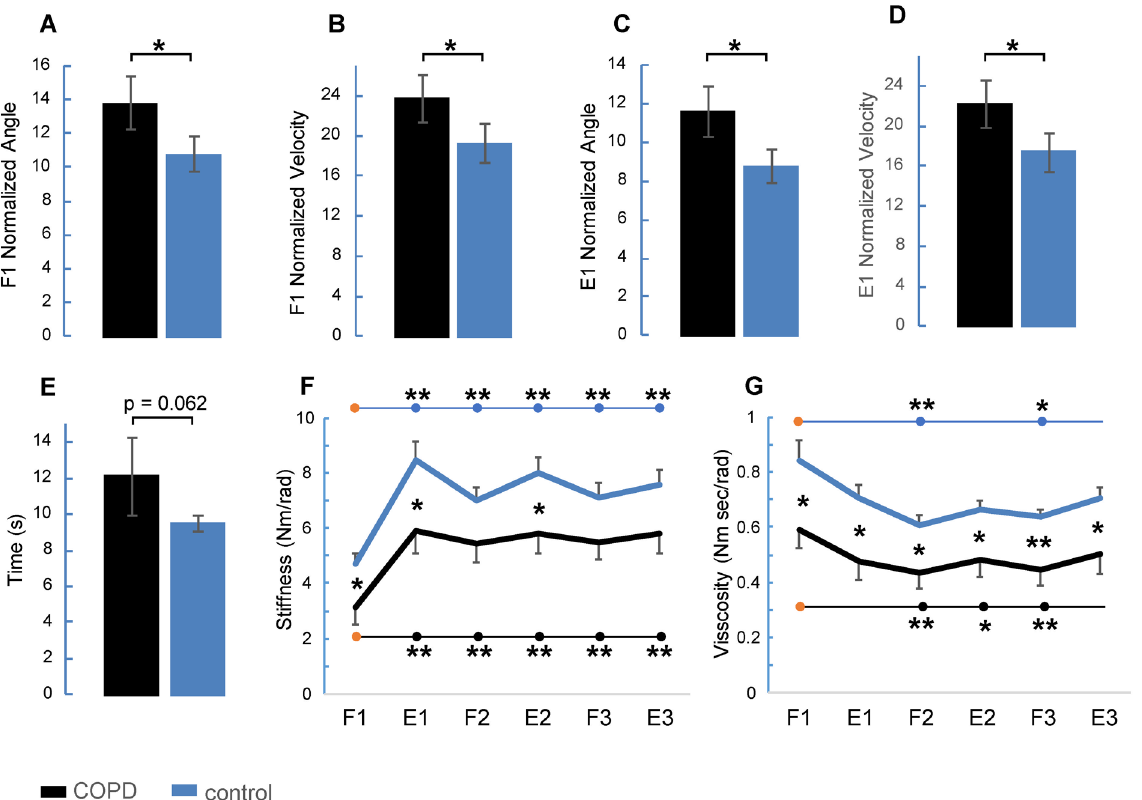
Figure 3. Statistical analysis of kinematic and viscoelastic data. Comparisons between COPD (black) and control (blue) groups for the following parameters: normalized angle ( A ) and velocity ( B ) during the first flexion; normalized angle ( C ) and velocity ( D ) during the first extension; total time of pendular leg oscillations ( E ). Changes in stiffness ( F ) and viscosity ( G ) estimated for COPD (black) and control (blue) groups over the first six hemicycles. Data are expressed as grand average and standard error. Symbols: *p < 0.05; **p < p = 0.001; controls: p < 0.001). A main effect of group (F 1,19 = 6.646, p = 0.018, η 2 p = 0.26) was also detected, but a significant decrease of RF activity was only observed in the group of patients for the extension movements (p = 0.047). The prevalence of the RF EMG activity is not surprising since the RF is a leg extensor muscle and the extension movements were executed against gravity. On the contrary, although the BF muscle acts as a leg flexor, no significant differences were found between movement directions (F 1,19 = 3.156, p = 0.546, η 2 p = 0.02) or groups (F The quantification of the contribution of active and passive parameters on determining the observed velocity movements was performed considering the changes in EMG area of RF and BF muscles and the values of stiff- ness and viscosity measured during the first extension and first flexion of the pendulum test. We used the values of the first two hemicycles for passive parameters (see Fig. 3F,G), since their kinematics were more comparable with the flexion and extension kinematics performed during the six leg oscillations of the active protocol. For an appropriate comparison between passive and active measurements, the data of the first flexion and first extension for stiffness and viscosity were recomputed because one patient did not participate in the active trial. The statistical results of this reworking are summarized in Fig. 5C,D. Stiffness and viscosity showed significant differences between movement direction (stiffness: F 1,19 = 38.210, p < 0.001, η 2 p = 0.67; viscosity: F 1,19 = 10.173, p = 0.005, η 2 p = 0.35) and between groups (stiffness: F 1,19 = 6.896, p = 0.017, η 2 p = 0.27; viscosity: F 1,19 = 7.246, p = 0.014, η 2 p = 0.28) for both the first extension (stiffness: p = 0.036; viscosity: p = 0.018) and the first flexion (stiffness: p = 0.029; viscosity: p = 0.029). From the multiple regression model represented by Eq. (2), a backward stepwise processing was adopted to find the best relationship between changes in velocity and changes in passive and active parameters during the extension and flexion voluntary movements. The results of this analysis, reported in Table 3, show that there were suitable levels of correlation strength (see columns related to R, R 2 and aR 2 ), a good level of statistical sig- nificance (see columns related to ANOVA) and, in the final models with more than one independent variable, acceptable range of VIF to conclude that there were no multicollinearity symptoms (see rows related to VIP for models associated with Extension Velocity). The RF activity and the level of passive tension were good predictors for the changes in velocity during leg extensions in both groups. However, considering the variables remained in the final models and their partial coefficients of correlation ( r ) and coefficient of determination ( r 2 ), the contribution derived from the RF activity